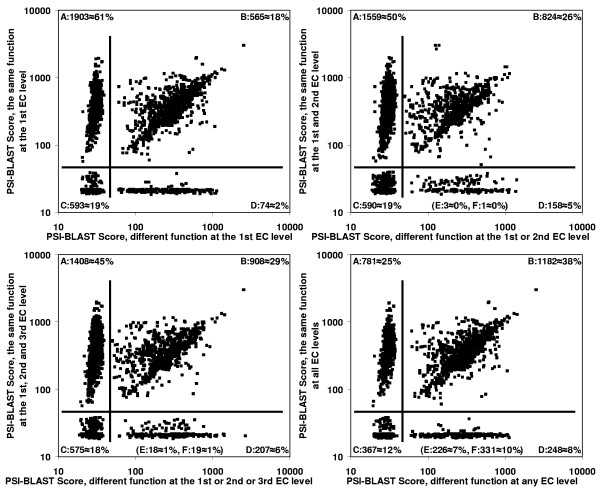
PSI-BLAST score of the most similar protein with the same enzyme function versus PSI-BLAST score of the most similar protein with different enzyme function at the 1st (upper left chart), 2nd (upper right chart), 3rd (lower left chart), and 4th EC level (lower right chart). Calculation was conducted for non-redundant set of 3,135 chain sequences (amino acid identity < 90%) of known structure and enzyme function. Each PSI-BLAST score was taken after the third iteration using 10,278 non-redundant sequence chains (including 3,135) from the Protein Data Bank to build a sequence profile. In each of the charts there are four clusters of points (A, B, C, and D) separated by the horizontal and vertical line. The A and C groups correspond to sequences that are not similar to any enzyme with a different EC number. Two other clusters (B and D) contain proteins from sequence superfamilies that have more than one function. Last two groups (E and F – not shown in the charts) include proteins of orphan function in this dataset. F group contains sequences which are significantly similar to other proteins, while E group corresponds to singleton sequences.